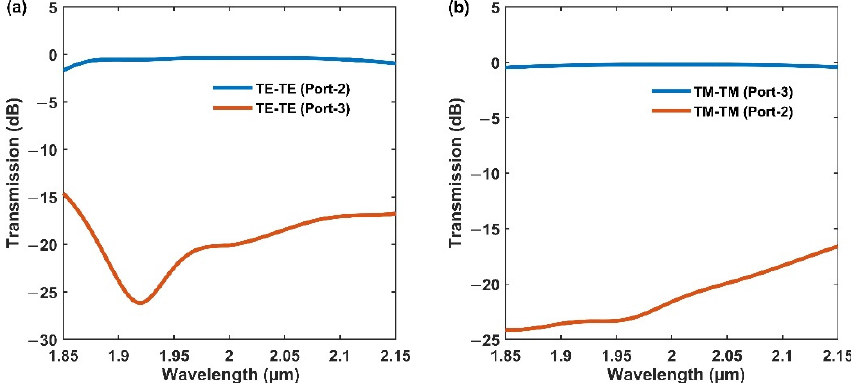
Figure 5. ( a ) and ( b ) are the transmission spectra of TE and TM modes for the digital-topology structure, respectively.